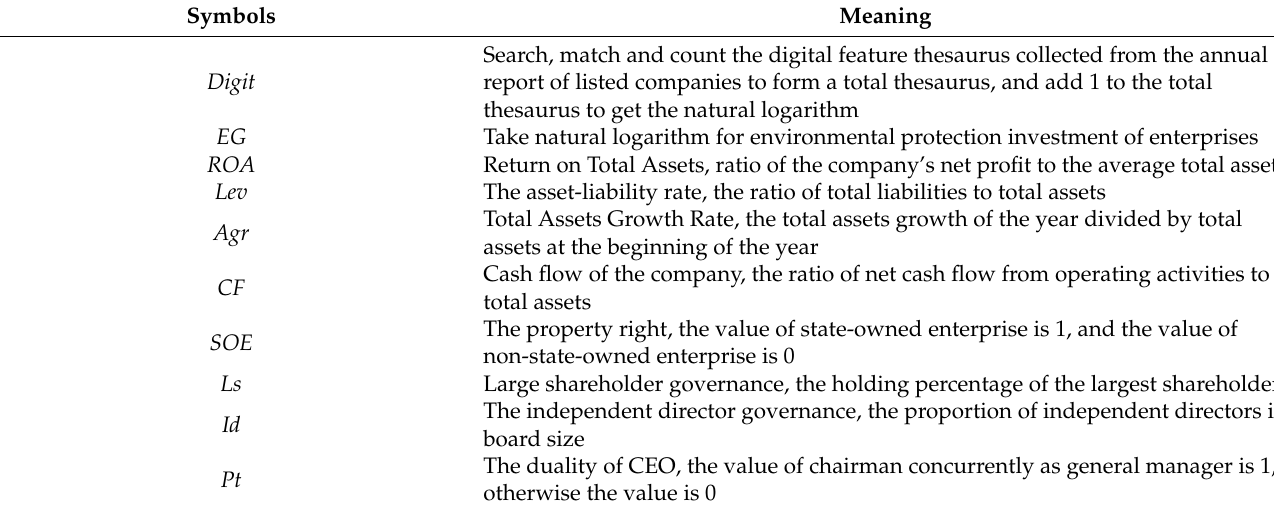
Table 1. The meanings of parameters, variables and